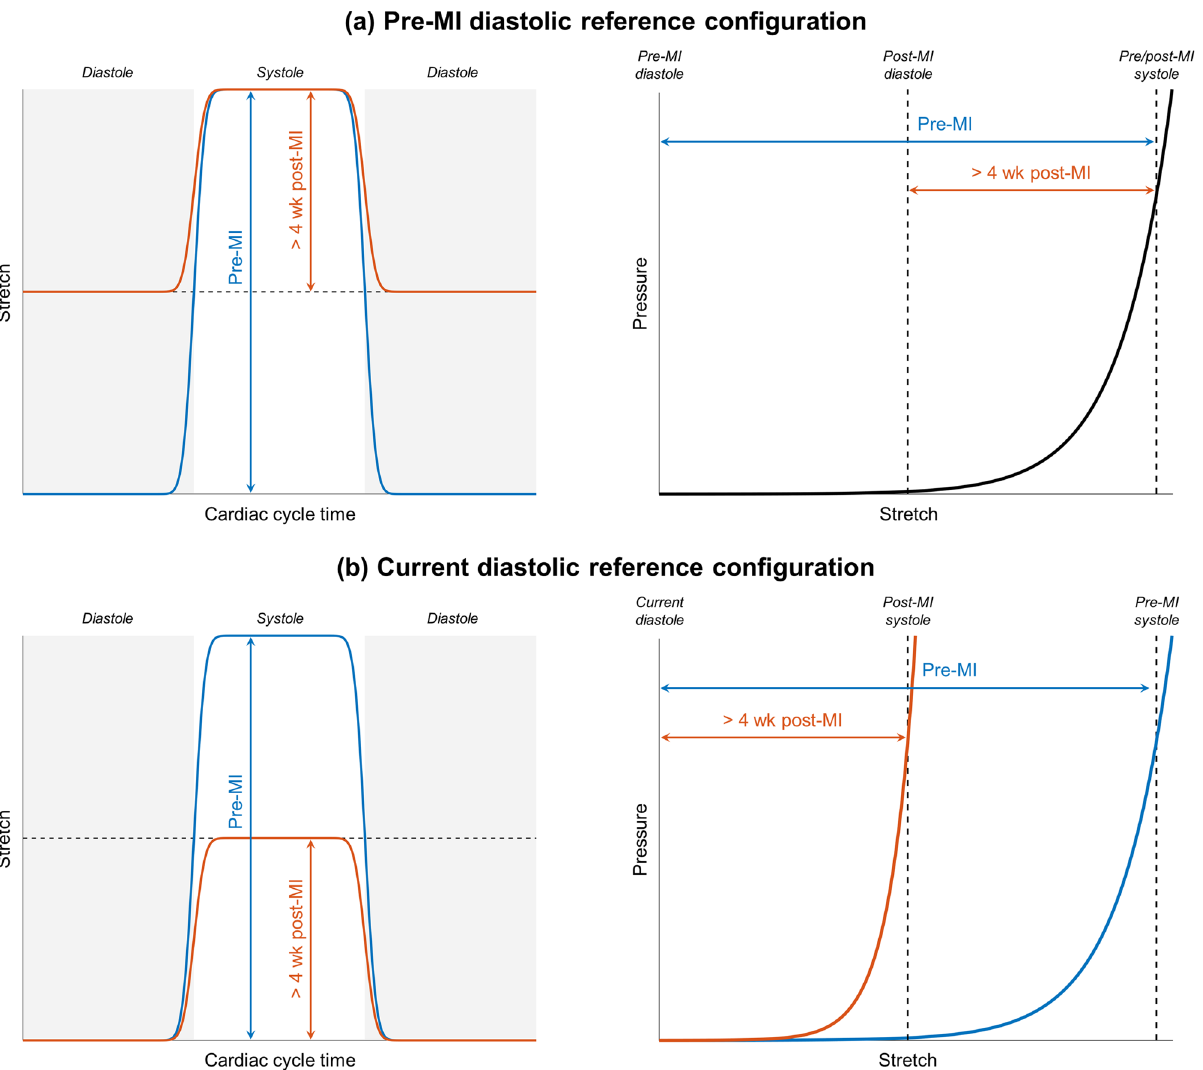
Figure 10. Schematic pressure waveforms and mechanical responses of the MV, referenced to ( a ) the pre-MI diastolic configuration and ( b ) the current time point’s diastolic configuration. While the leaflet’s total stretch in systole remains essentially constant ( a ), the range of stretch experienced over the cardiac cycle is substantially narrowed due to permanent diastolic distention, especially in the radial direction (Figs. 3, 6). This causes the leaflet tissue to behave more stiffly with respect to its current diastolic configuration ( b